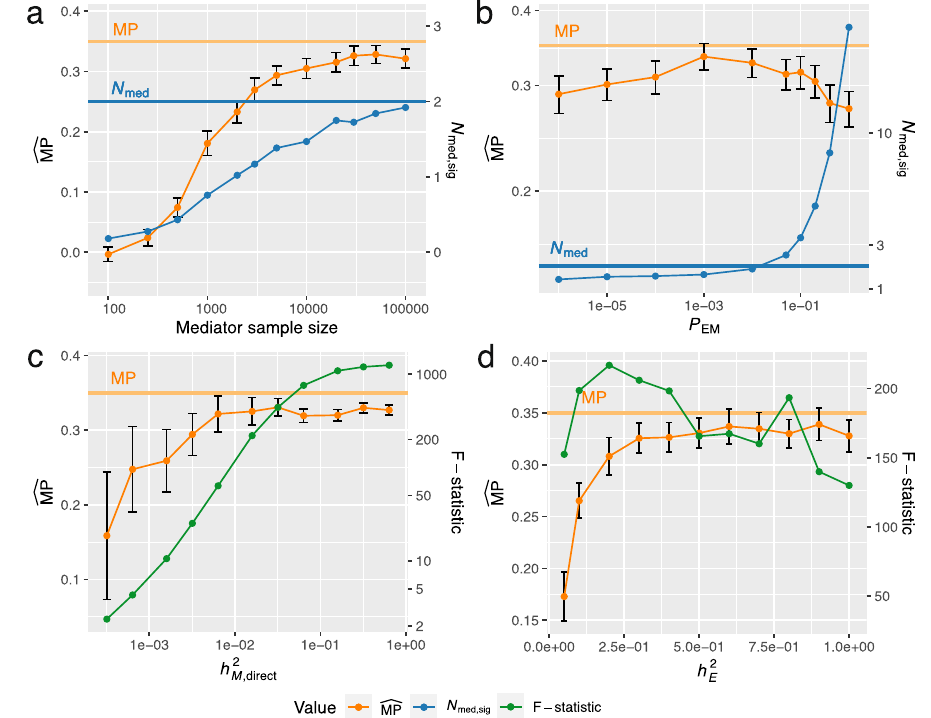
Fig.2|Simulationresultstoassessthebiasinestimatedmediationproportions ( d MP s) in real data settings. a In fl uence of the mediator sample size on the esti- mated d MP (orange) and number of selected mediators ( N med,sig , blue). b In fl uence of the mediator selection threshold P EM . c , d Sensitivity of d MPs in settings of weak instruments, simulated by low mediator ( h 2 M ,direct ) and exposure ( h 2 E ) cis -herit- abilities, respectively. Conditional F-statistics (green) of the exposure allow to test